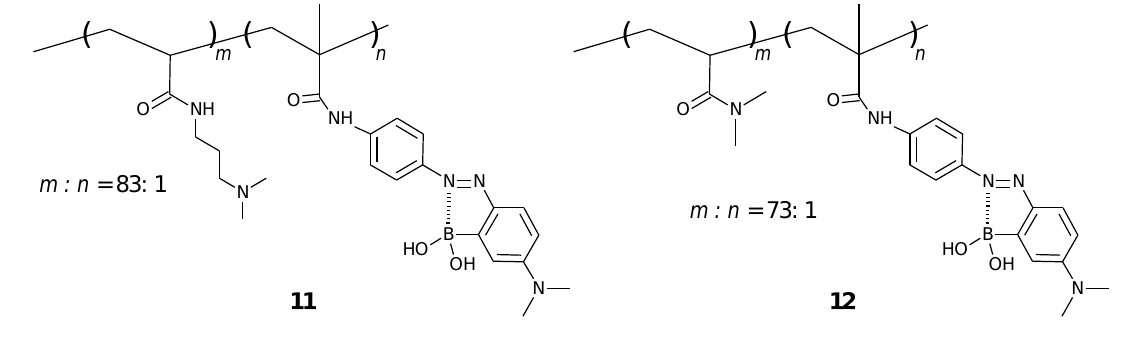
Figure 13. Chemical structures of 11 and 12